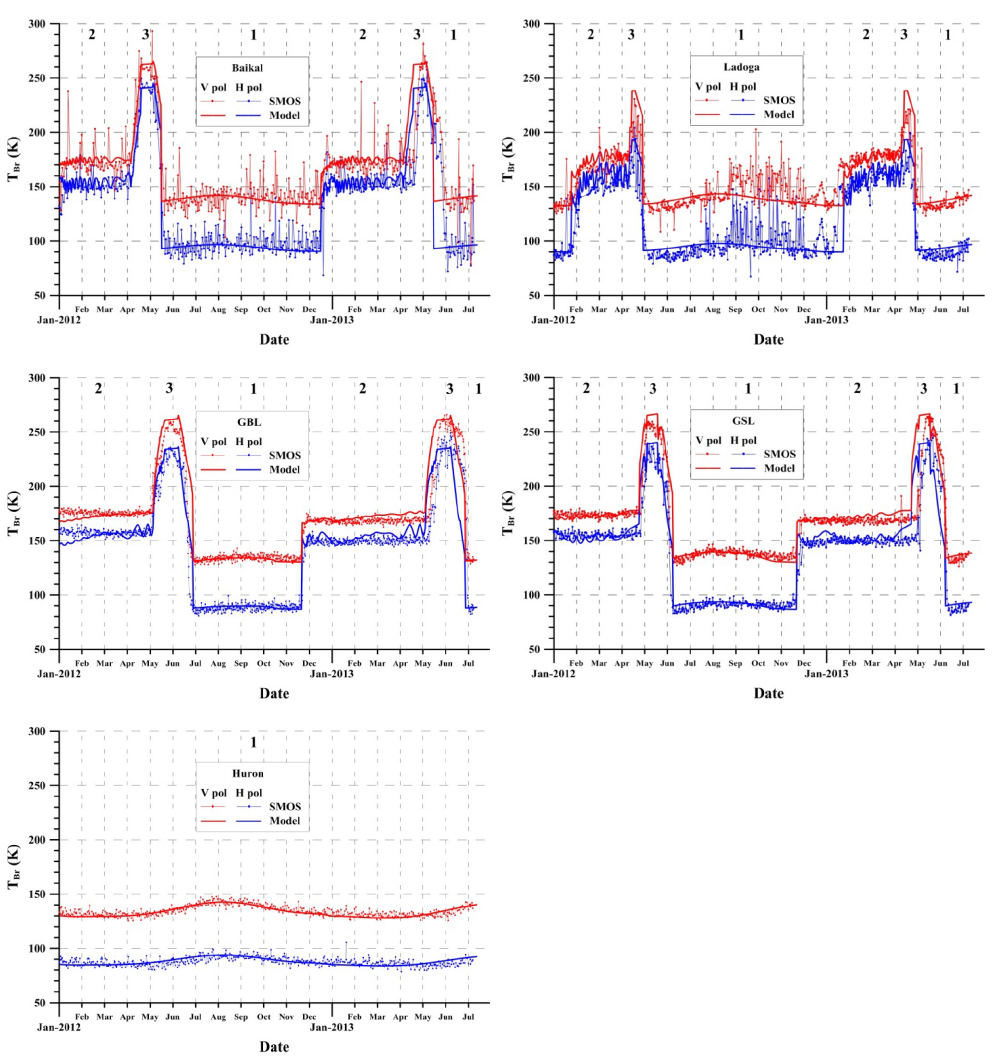
Figure 5. Seasonal variations of brightness temperature within the SMOS L1C grid cells for Baikal, Ladoga, GBL, GSL, and Huron. Thin lines and symbols denote the SMOS data, thick lines represent the model results. Numbers mark brightness temperature TRs associated with open water surface (TR1); complete ice cover (TR2); and ice deterioration and melt (TR3) (see